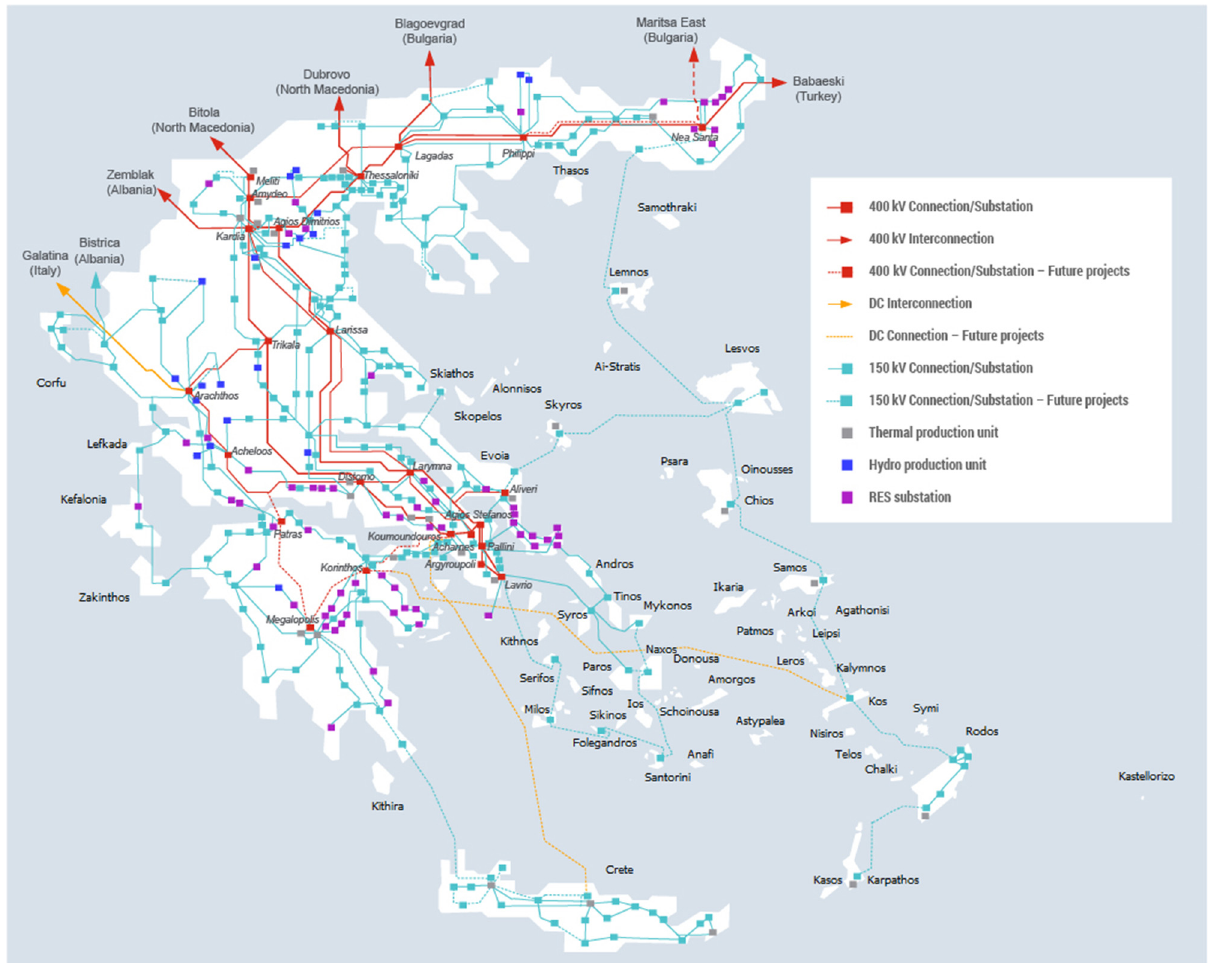
Figure 5. System development planning of the Dodecanese and Northeast Aegean Islands interconnection in the case of scenario B. The rest of the Cycladic Islands and Crete interconnections are currently projects in the implementation